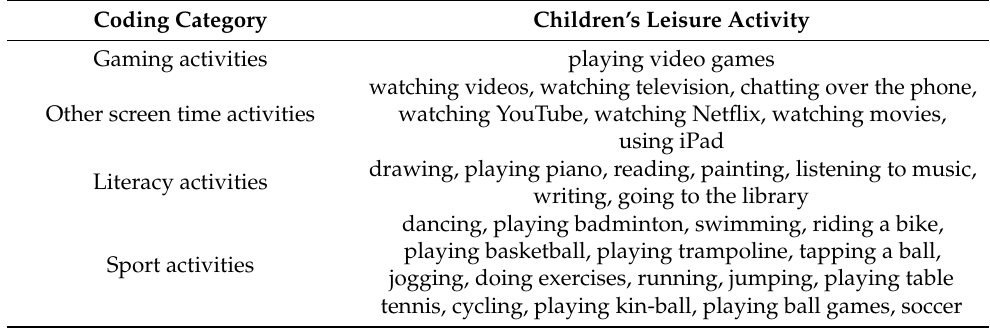
Table 1. Coding categories and children’s leisure activities reported by parent